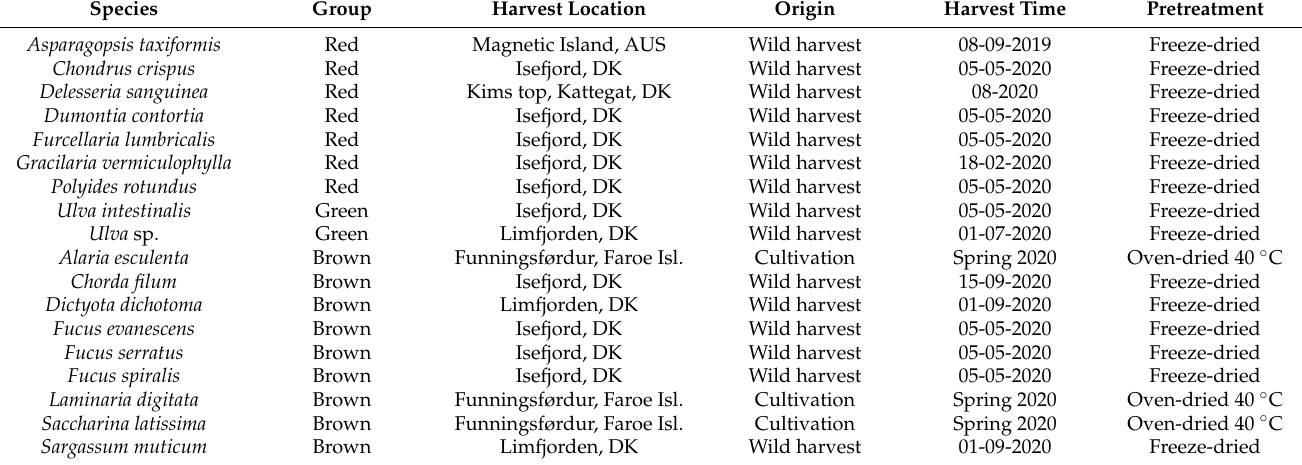
Table 2. Overview of seaweed species used in the analyses. The eighteen species included red, green and brown species harvested in Nordic waters or in Australia from either wild harvesting of natural populations or from kelp species cultivated on longline systems in the Faroe